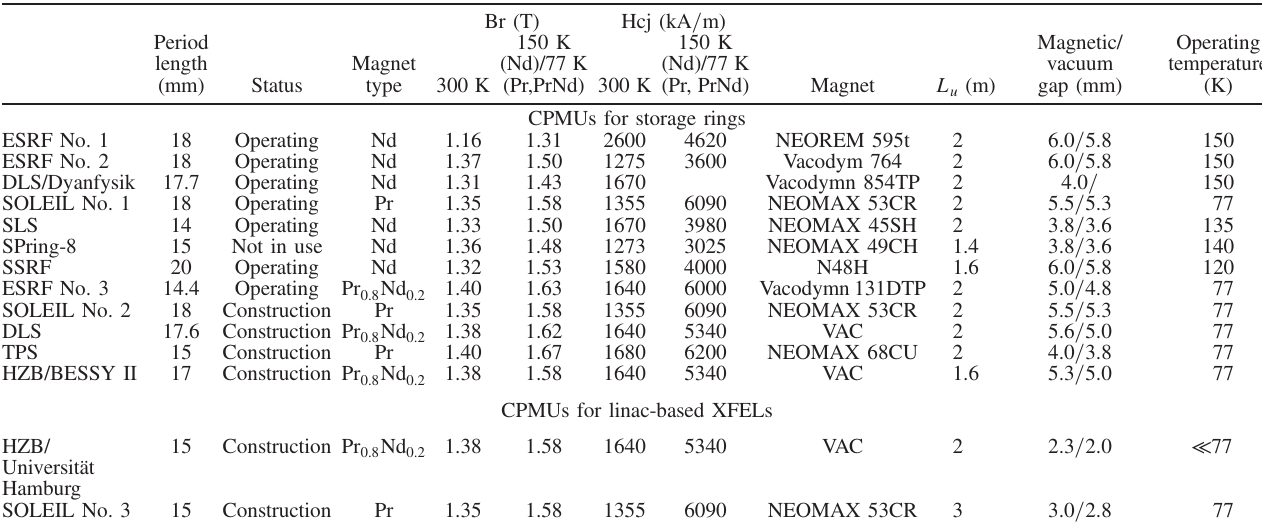
TABLE II. Development of CPMUs around the world.